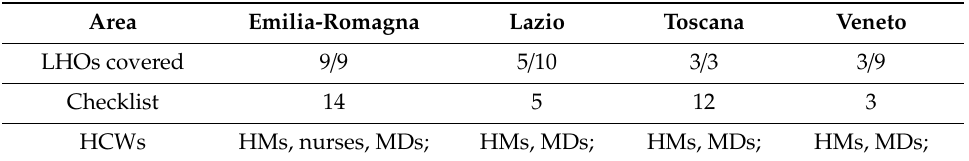
Table 2. Summary of Checklists.